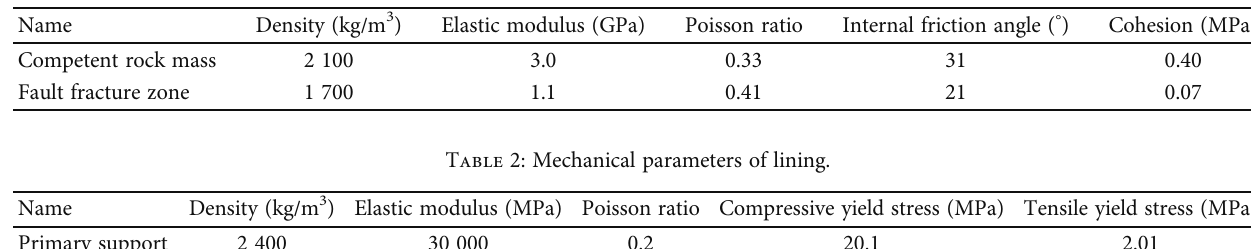
Figure 2: The diagram of calculation model. (a) Overall calculation model. (b) Tunnel lining. (c) Schematic diagram of i element. Table 1: Rock mechanical parameters.